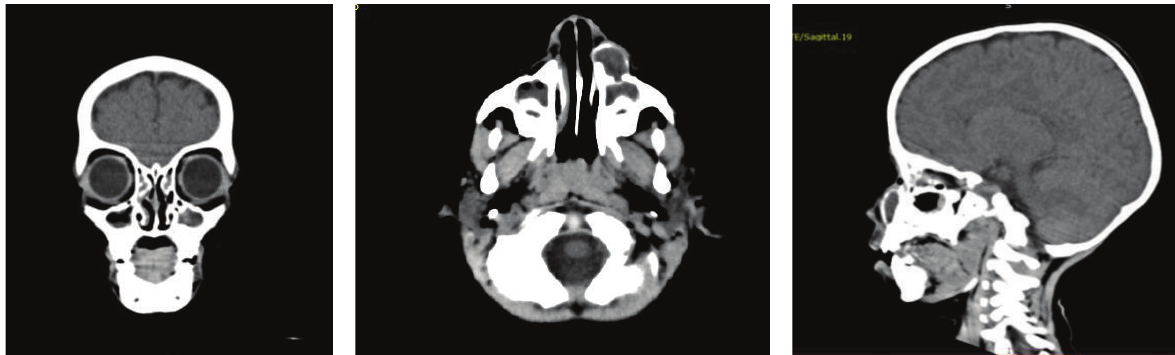
Figure 2: Coronal axial and sagittal CT: odontogenic myxoma left maxilla.